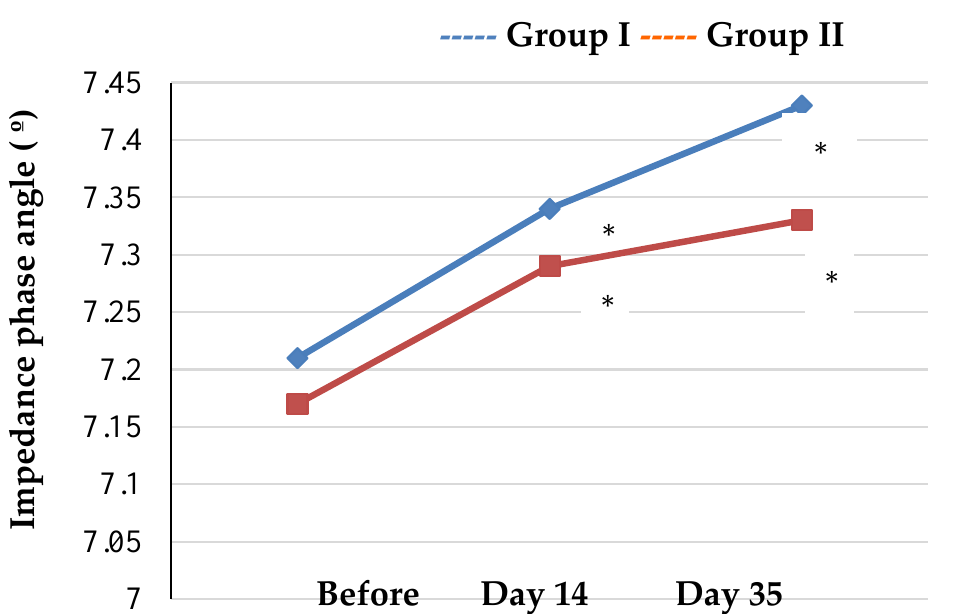
ʹp < 0.001— statistical significance of differences compared to the baseline.